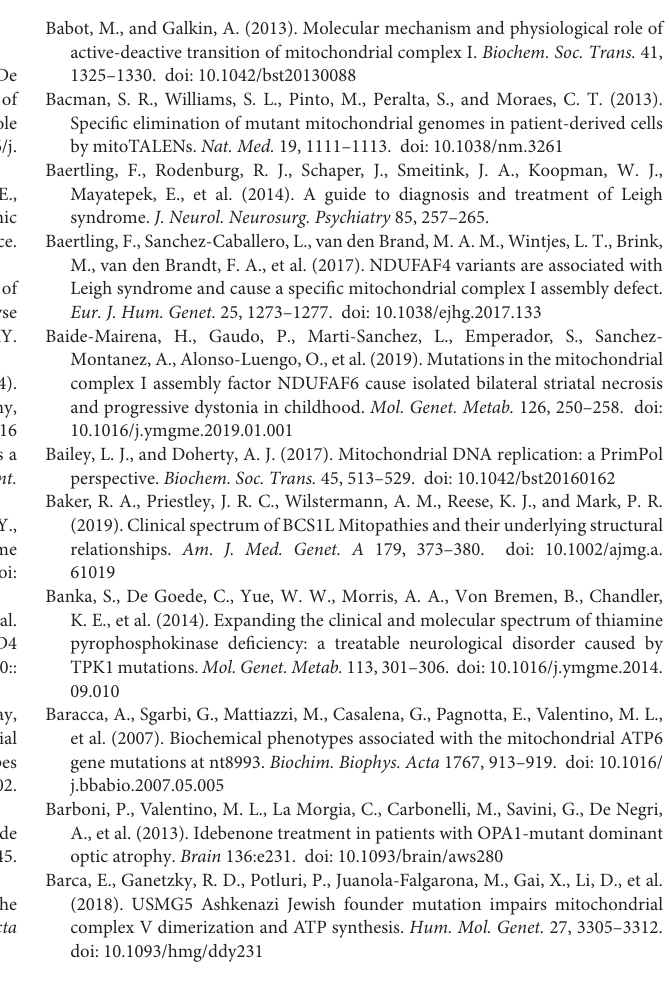
Supplementary Table 1 | Nuclear genes involved in LS and LS-like disorders. Supplementary Table 2 | Mitochondrial genes involved in LS and LS-like